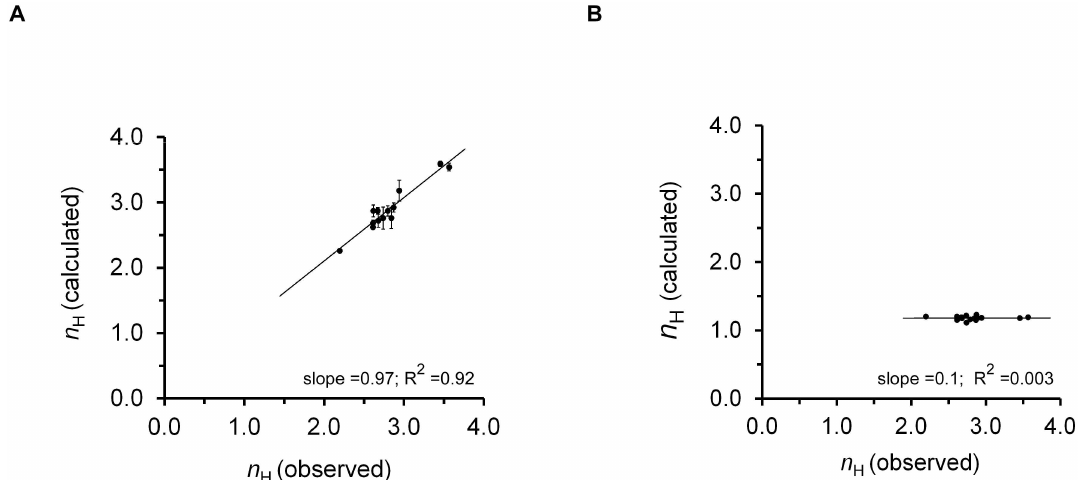
Fig 1. Successful application of the three-equation system(TES) strategy in the case of evolutionary variations in hemoglobin. (A) Correlation plot relatingthe values of n H for the 13 different mammalian hemoglobinsof the physiologically- sound solutionset derived either using the Hill equation (as reportedin ref. [33]) or calculatedaccordingto the MWC model, based on L , K R and K T values (Table 1, red columns). Values for the humanand elephantspecies correspond to the averagedvalues of three independenttriplicates. (B) The same analysisbut for the non-physiologicalsolution set (Table 1, rightmost black columns). The expressionfor n H in terms of the L , K R and K T model parameters is known and can be = 1 (cid:0) (cid:22) Y Þ =@ ð log ½ S (cid:138)Þ Hill transformation (see Eq 4 and Methods). obtainedusing the @ ð (cid:22) Y MWC MWC